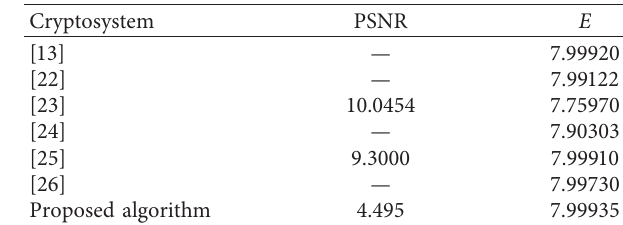
Figure 4: Histogram of the original images and their corresponding encrypted images. Table 1: PSNR, SSIM, NC, and E values of the encrypted image. Table 2: Comparative study of the PSNR and E values for the Lena